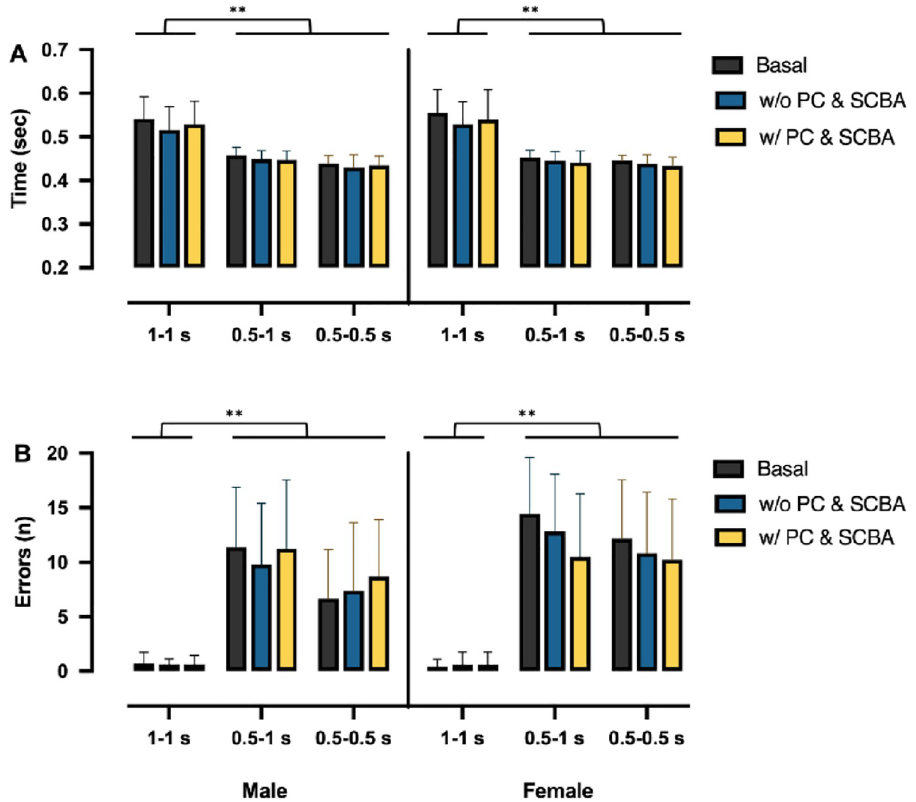
Fig 4. Means and standard deviations of the mean reaction time (A) and errors made (B), in males (left) and females (right), for each trail (1–1 s; 0.5–1 s, 0.5–0.5 s), in the three conditions: Basal (before the step test; black columns), without equipment (after step test with only protective clothing, w/o PC & SCBA; blue columns), and with equipment (after step test with protective clothing and Self-Contained Breathing Apparatus, w/ PC & SCBA; yellow